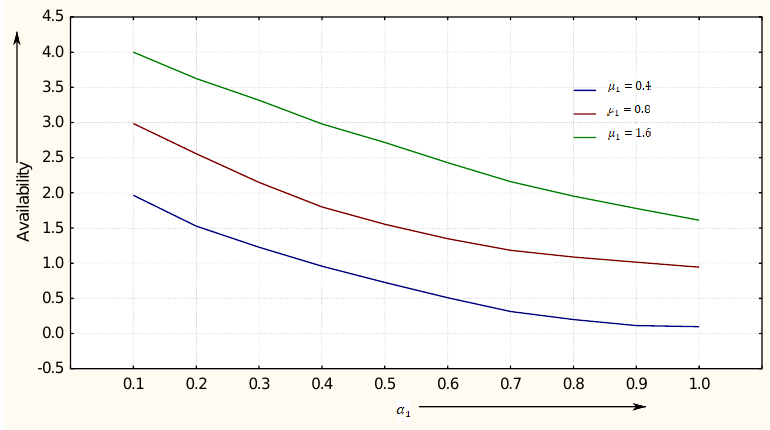
Figure 6. Behaviour of availability w.r.t 𝛼